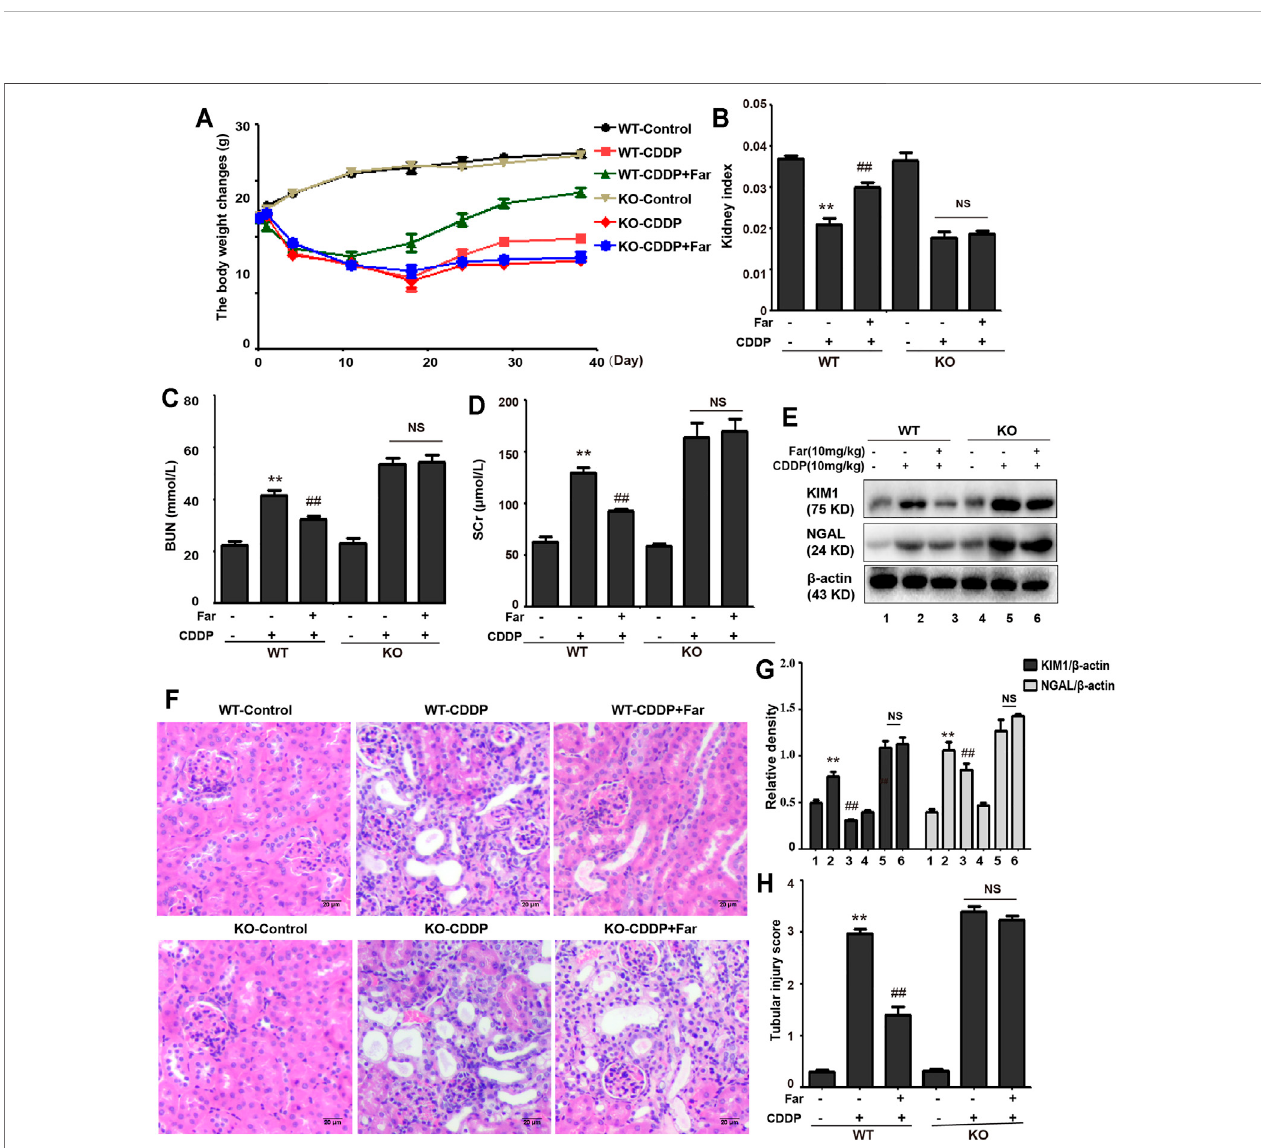
FIGURE 5 | Nrf2 knockout exacerbates CDDP-induced kidney damage. C57BL/6 wild-type mice and Nrf2 knockout C57BL/6 mice were treated with cisplatin intraperitoneally on day 0 and day 7 (10 mg/kg per dose). Then, the mice were sacri fi ced on the 31st day after the second administration of CDDP, and kidneys and whole blood were collected. Changes in weight (A) and kidney index (B) of wild-type and Nrf2 knockout mice were evaluated. The collected whole blood was used to measure BUN (C) and SCr (D) . (E,F) Kidney tissue lysates were analyzed by immunoblotting with speci fi c antibodies against KIM1 and NGAL. (G,H) Typical photomicrographs of kidney sections were used to quantify kidney damage. The data are shown as the mean ± SEM ( n (cid:1) 6 in each group). All experiments were performedthreetimes.* p < 0.05and** p < 0.01comparedwiththecontrolgroup; # p < 0.05and ## p < 0.01comparedwiththeCDDPgroup.NS,nospeci fi city;WT,wild- type C57BL/6 mice; KO, Nrf2 knockout C57BL/6